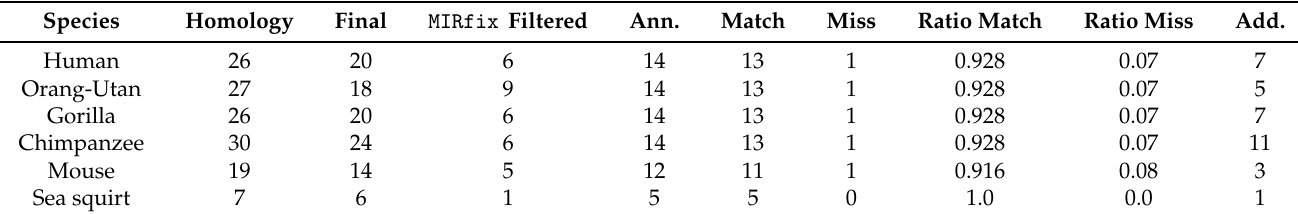
Table 1. Re-annotation of the let-7 family. For each species the number of loci annotated by miRNAture is shown at the homology stage (Homology) and after the evaluation stage (Final) and compared with the gold standard annotation merged from miRBase and Hertel et al. [40] (Annotation). We show how often the genomic coordinates from annotation match with candidate region (Match) or are not in the final candidate set (Miss) and the respective ratio over the total number of annotated regions. Candidates which pass the evaluation stage but do not overlap with annotation are counted as Additional. Labels: Ann. : Annotation, Add. :